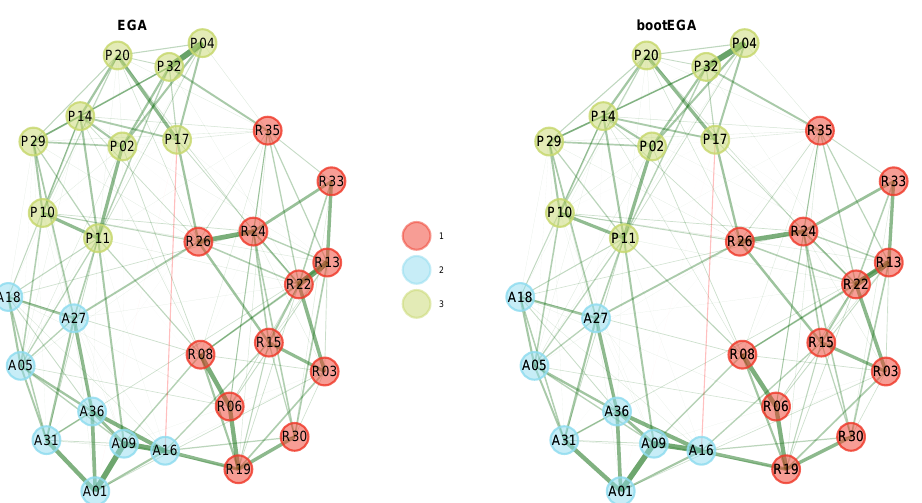
Figure 6. Dimensionality results for EGA ( left ) and bootEGA ( right ) for the Broad Autism Phenotype Questionnaire with unstable items